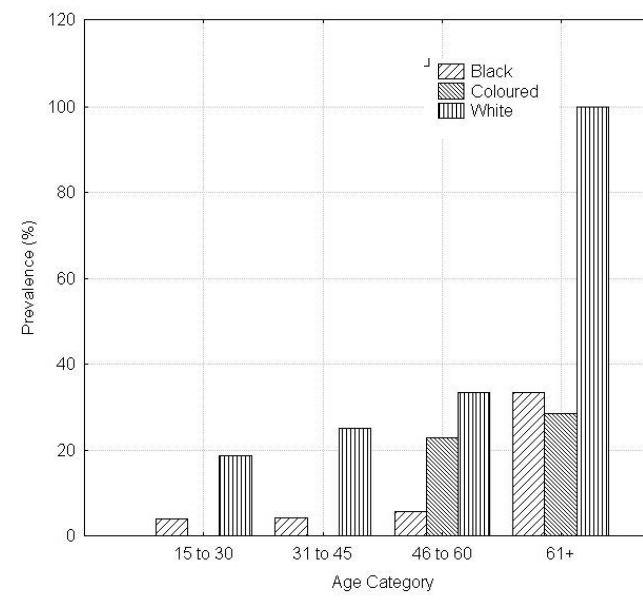
Figure 4 Histogram of hyperopia distribution by race